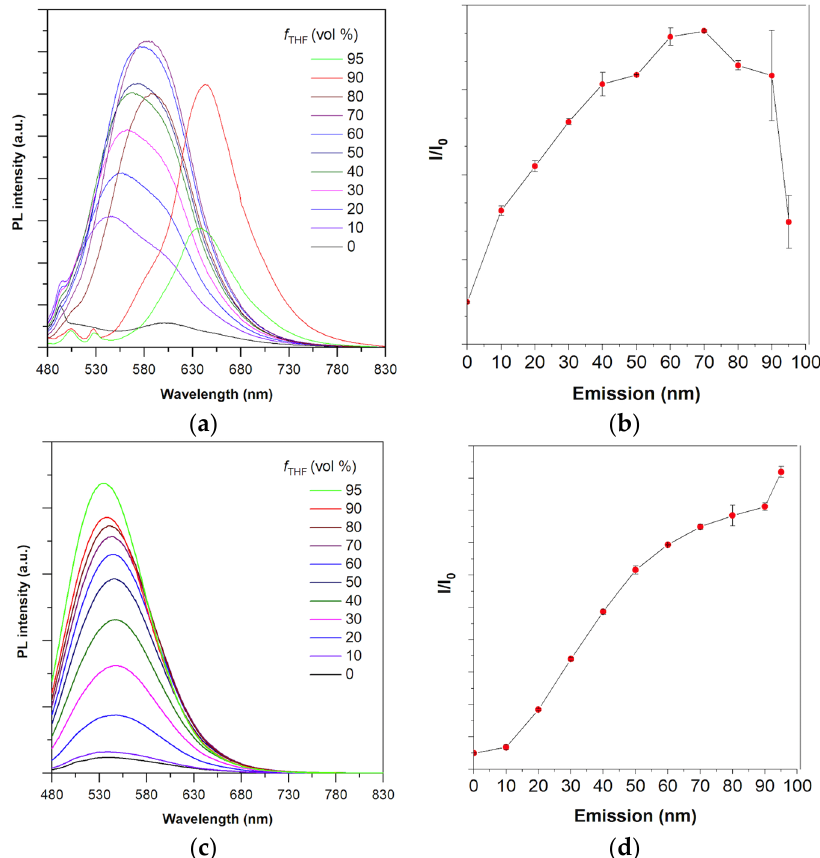
Figure 3. Photophysical properties of HCA and HCAP. ( a ) PL spectra of HCA (10 μ M) in THF/water mixtures with different water fractions. ( b ) Plot of relative PL intensity (I/I 0 ) versus the composition of the aqueous mixture of HCA. I 0 = PL intensity in pure THF. ( c ) PL spectra of HCAP (10 μ M) in water/THF mixtures with different THF fractions. ( d ) Plot of relative PL intensity (I/I 0 ) versus the composition of the aqueous mixture of HCAP. I 0 = PL intensity in pure water.